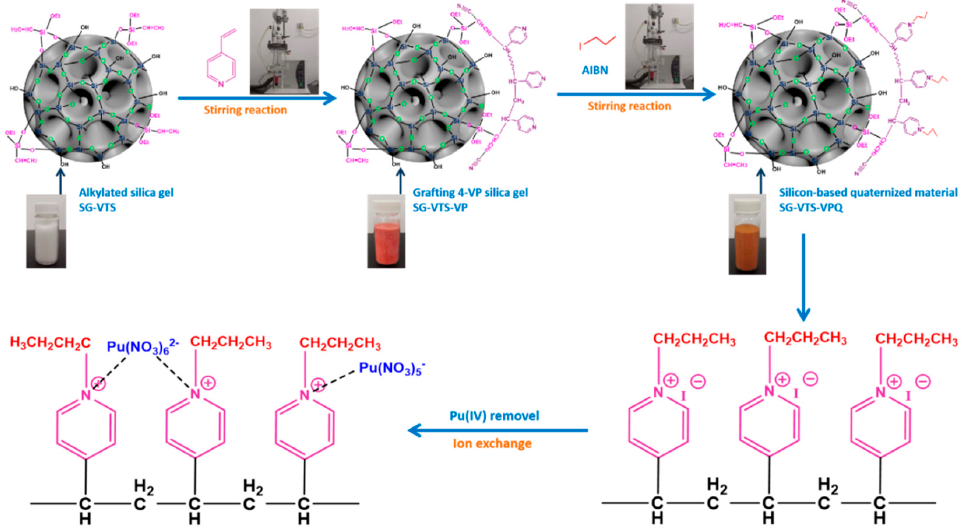
Figure 2. Preparation process of SG-VTS-VPQ and adsorption process of Pu(IV).